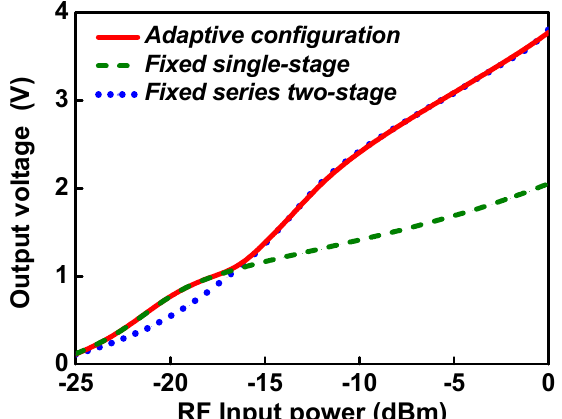
Figure 7. Output voltage according to RF input power for each rectifier configuration.